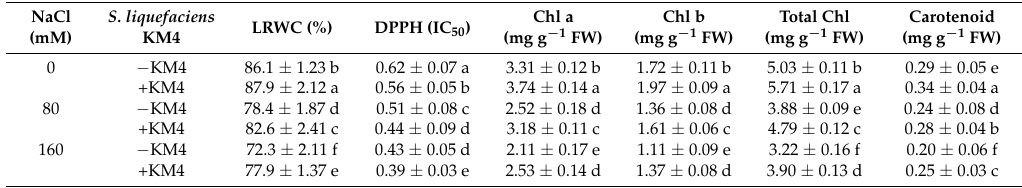
Table 3. Leaf relative water content (LRWC), antioxidant activity (DPPH, µ g mL − 1 ), and contents of chlorophyll (Chl) and carotenoid in maize leaves in the presence or absence of Serratia liquefaciens KM4 under saline conditions.